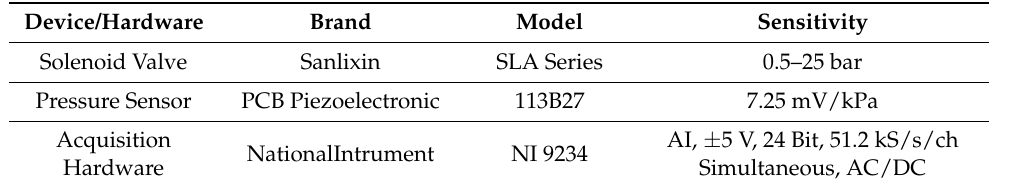
Table 1. Device and Hardware Specification.